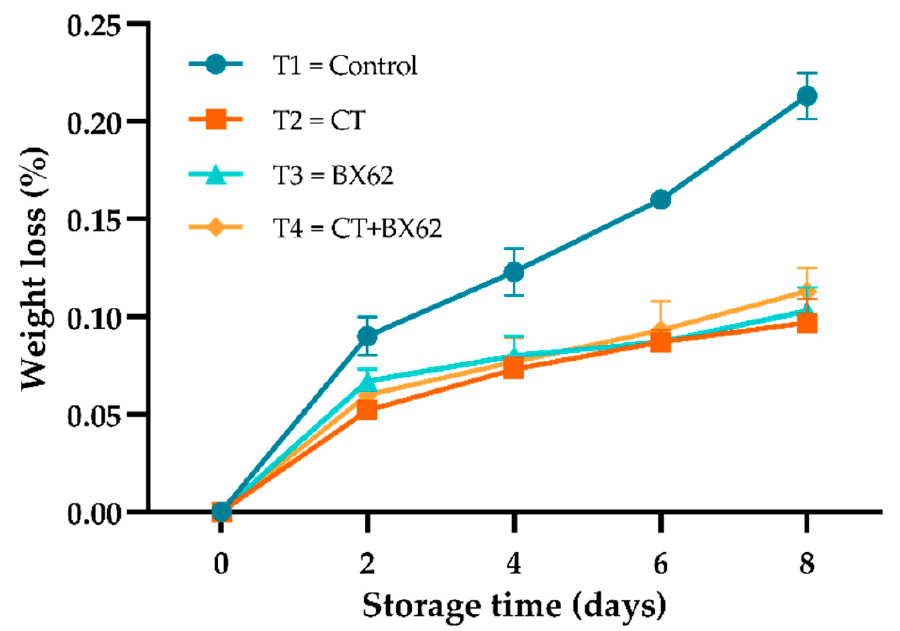
Figure 1. Changes in weight loss rate for the control apples ( ● ), chitosan-treated (CT) apples ( ■ ), L. plantarum BX62-treated (BX62) apples ( ▲ ), and chitosan in combination with L. plantarum BX62-treated (CT + BX62) apples ( ◆ ) after being stored at 4 °C for 8 days. Each data point is the mean of three replicate samples.